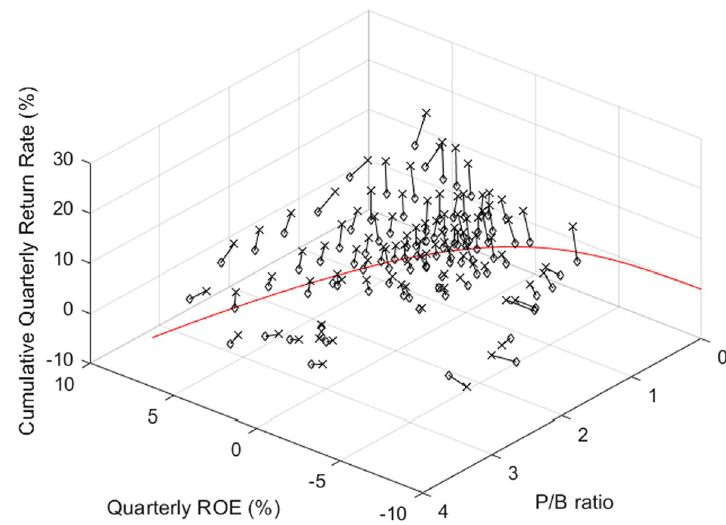
Fig. 30 The relationships among ROE, P/B, and cumulative quarterly return rates (diamond: the data in the t 1 Quarter, x‑mark: the data in the t +